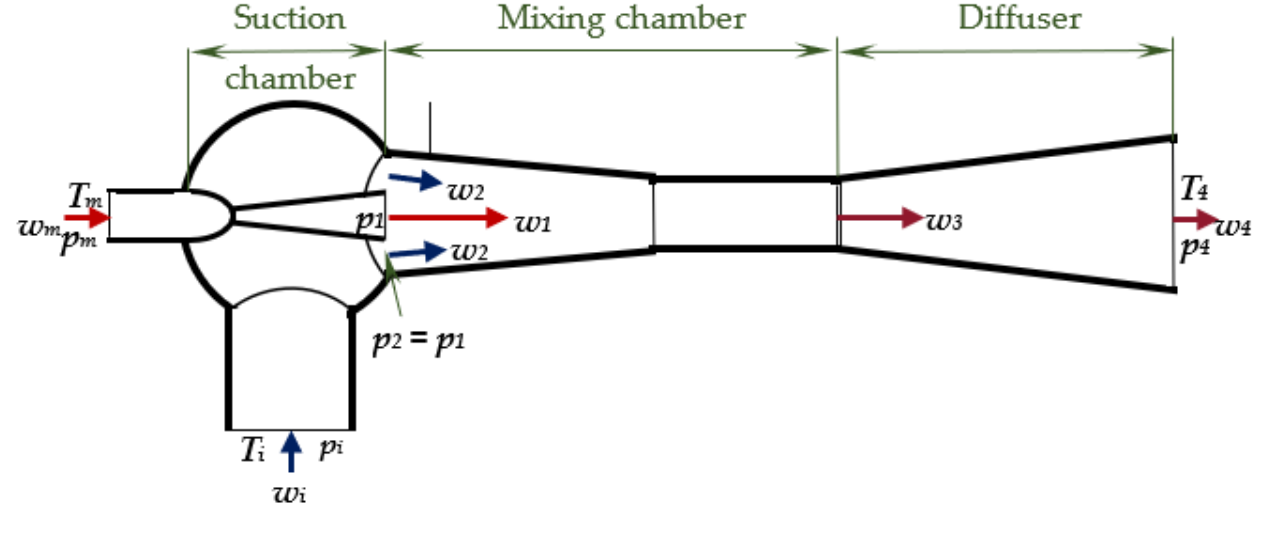
Figure 1. General schematic of an ejector: The motive gas enters on the left with mass flow rate G m ; the induced gas enters from below with mass flow rate G i .